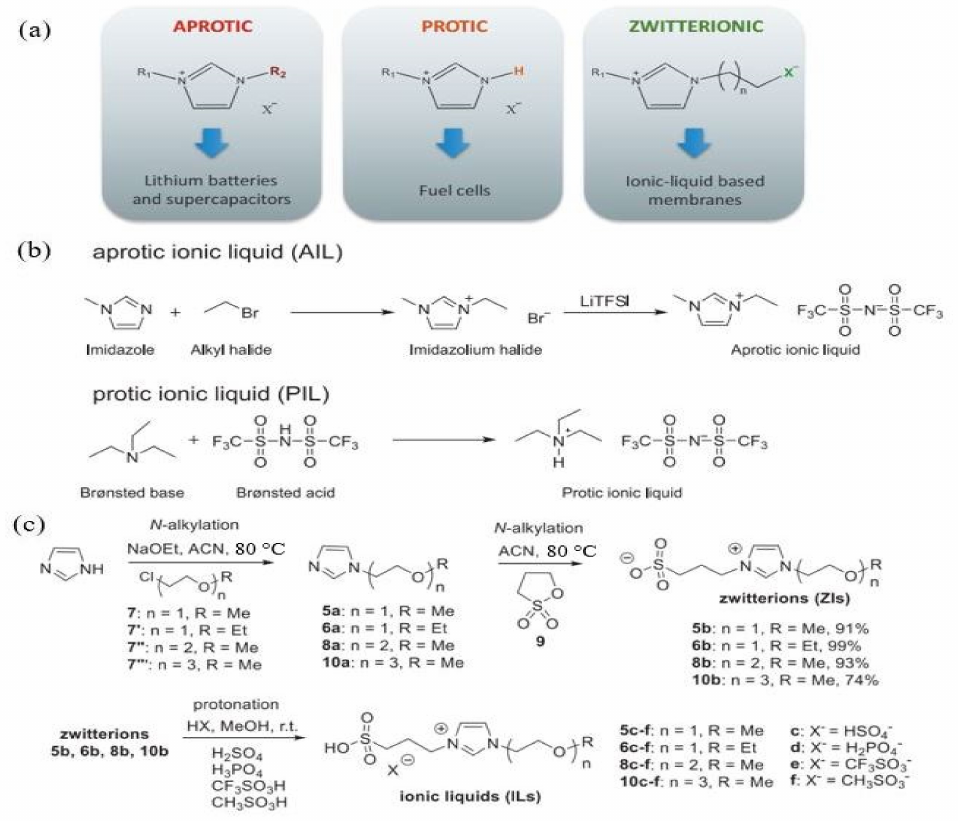
Figure 6. ( a ) Class of ionic liquid compounds and their specific applications [84]; ( b ) preparation of aprotic and protic ionic liquids [89]; ( c ) synthesis of zwitterion ionic liquids